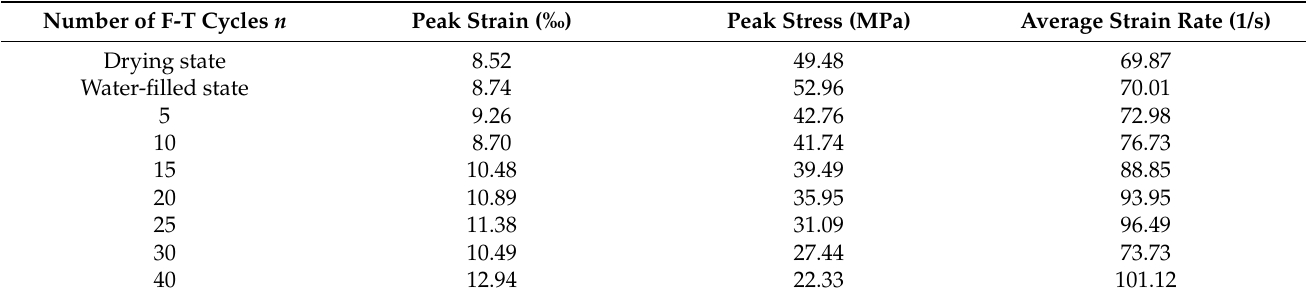
Table 2. Dynamic parameters of siltstones under the F-T effect.